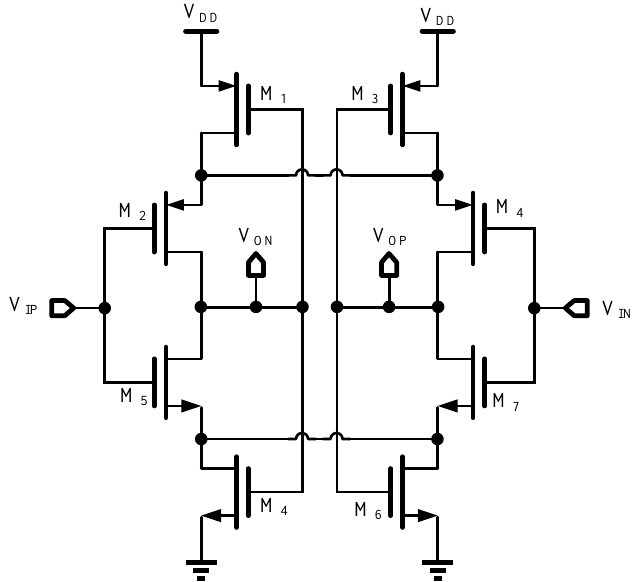
Figure 9. Self-biased zero-crossing detector